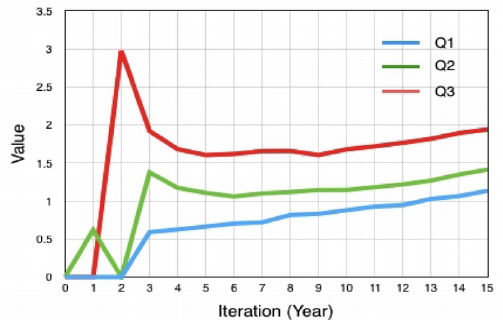
Figure 9. Value Co-creation Obtained by